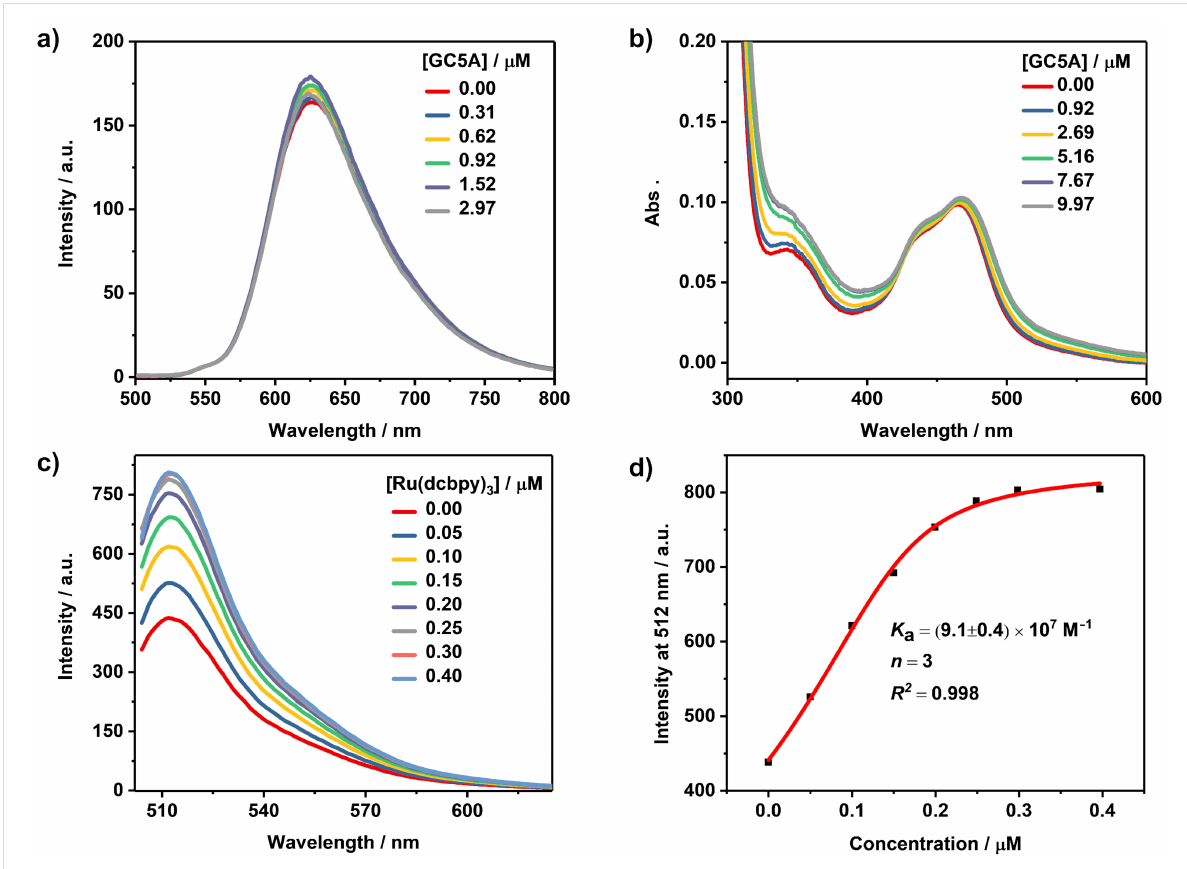
Figure 4: (a) Direct fluorescence titration ( λ ex = 465 nm) of Ru(dcbpy) 3 (1.0 μ M) with GC5A. (b) Direct absorption titration of Ru(dcbpy) 3 (5.0 μ M) with GC5A. (c) Competitive fluorescence titration of GC5A–Fl (0.5/0.5 μ M) with Ru(dcbpy) 3 , λ ex = 500 nm. (d) The associated titration curve at λ em = 512 nm fitting according to a n :1 competitive binding model. All measurements were performed in HEPES buffer (10 mM, pH 7.4) at 25 °C.